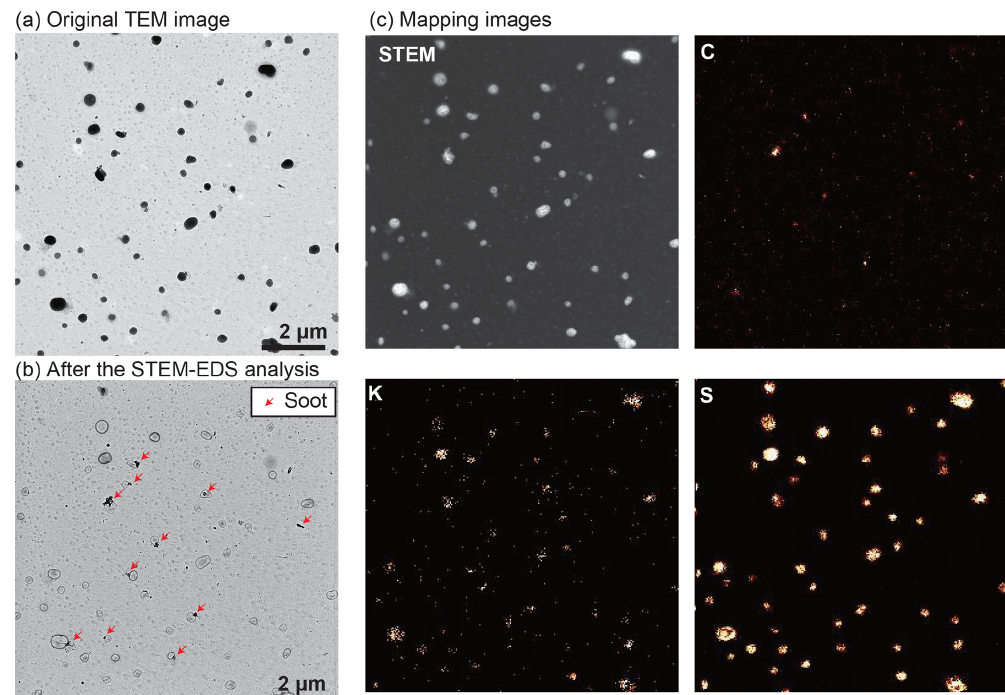
Figure 5. TEM (a, b) and elemental mapping images (c) of an ambient aerosol sample with a relatively high K-bearing particle fraction (58%). (a) The TEM image shows the shapes of original particles before STEM-EDS mapping analysis. (b) The TEM image shows the same area after the STEM-EDS measurement. After removing potassium sulfates, internally mixed soot particles became apparent (red arrows). (c) STEM and elemental mapping images of C, K, and S. The distribution of C corresponds to soot particles. The distribution of S represents sulfates with and without K. The sample was collected on 29 April 2019